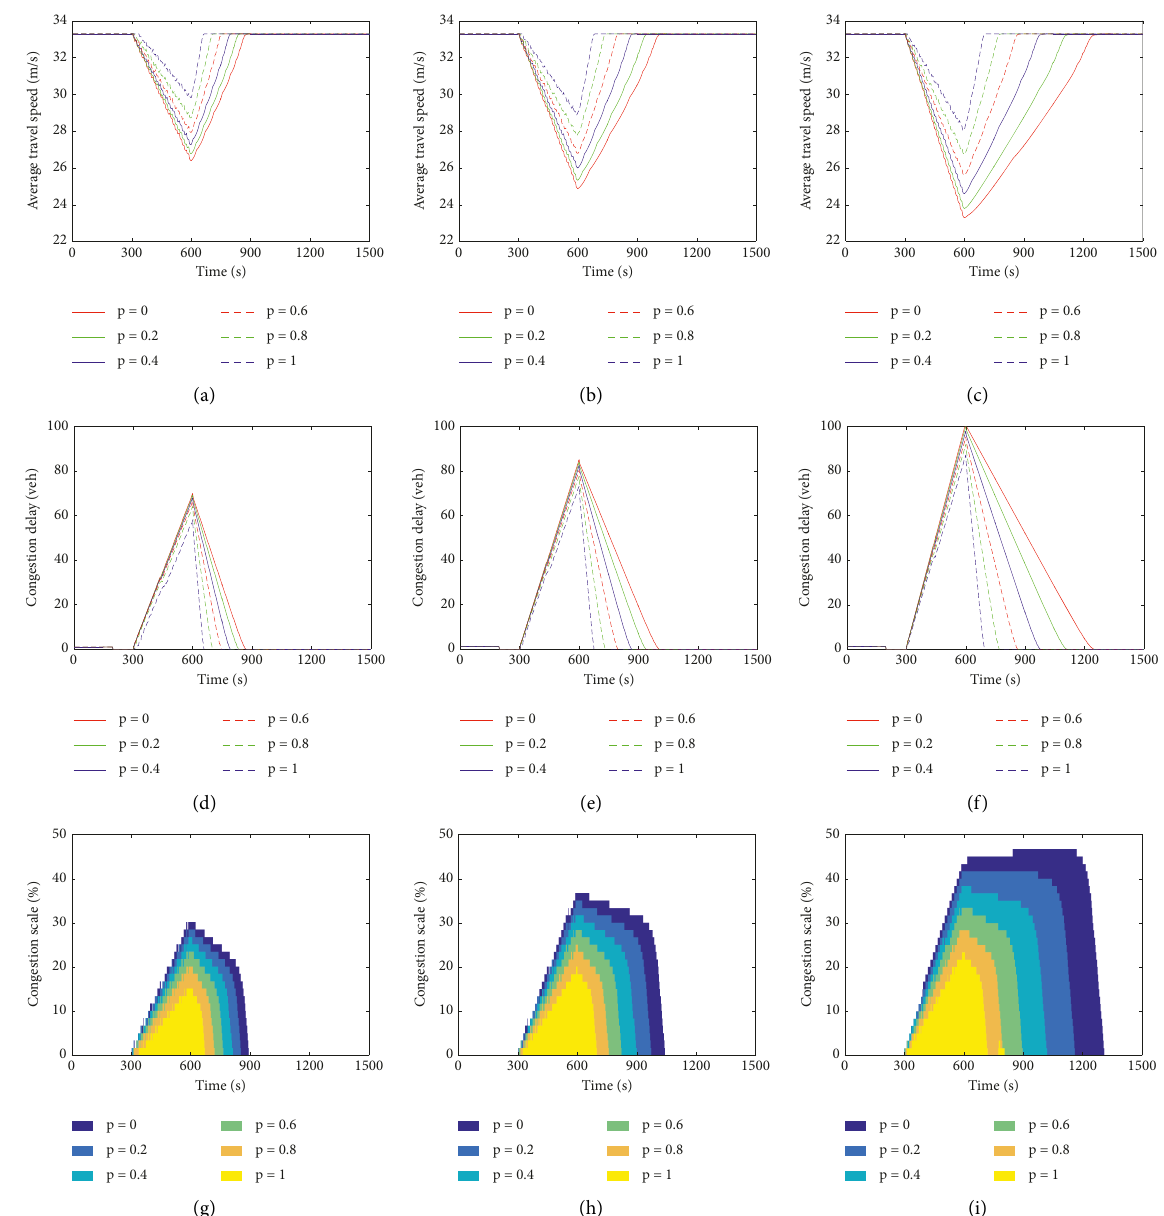
Figure 10: The results under different traffic demands: (a) average travel speed (1,200veh/h), (b) average travel speed (1,400veh/h), (c) average travel speed (1,600veh/h), (d) congestion delay (1,200veh/h), (e) congestion delay (1,400veh/h), (f) congestion delay (1,600veh/ h), (g) congestion scale (1,200veh/h), (h) congestion scale (1,400veh/h), and (i) congestion scale